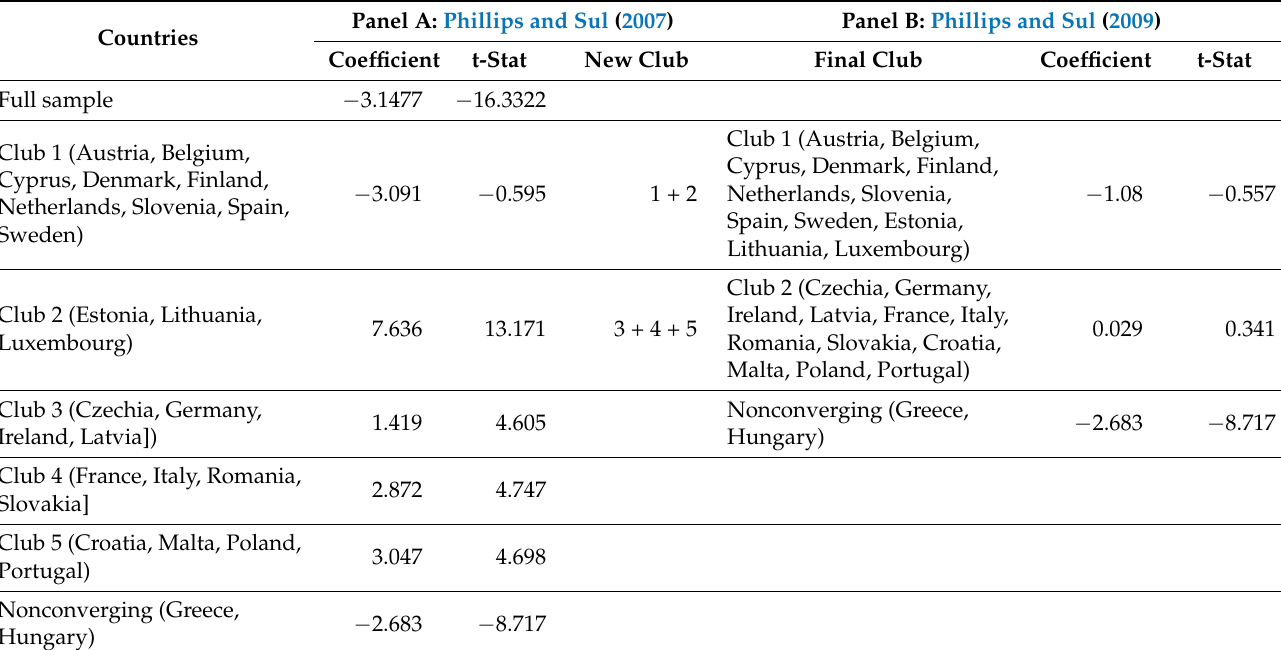
Table 3. Country convergence for the period 1995–2008 (deficit to GDP ratio).